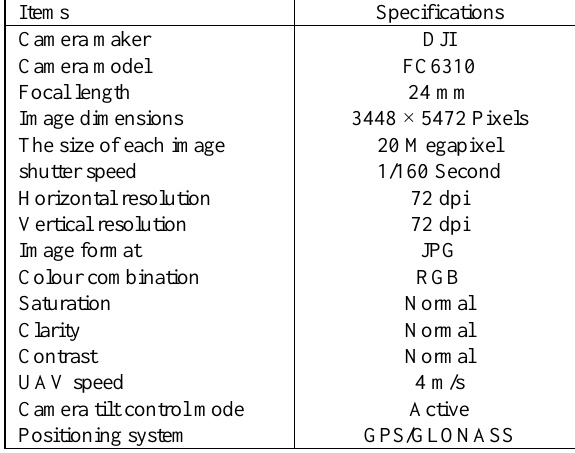
Table 1. Specifications of the UAV camera and digital aerial images used in the present study.